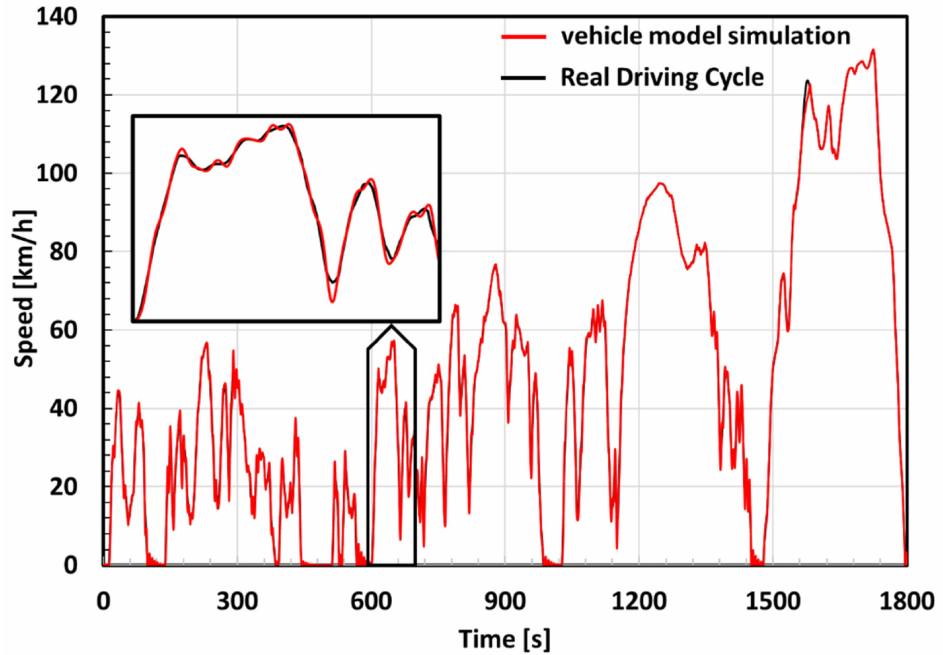
Figure 3. Comparison between WLTP CLASS 3B driving cycle and vehicle model